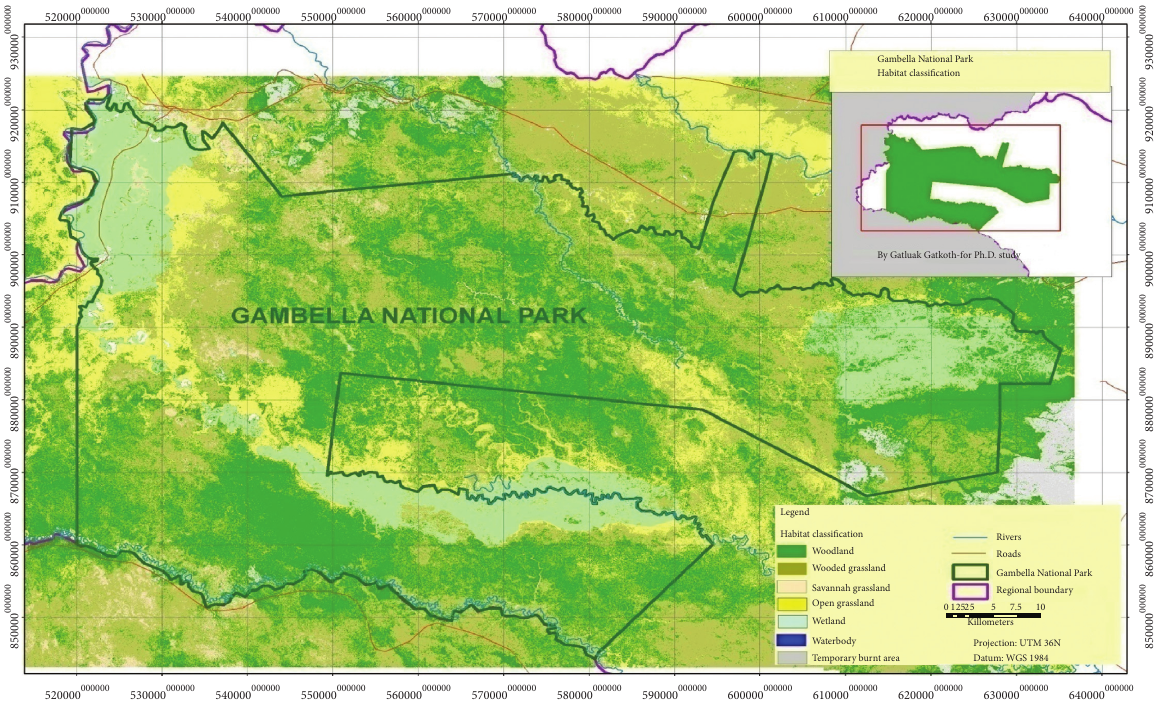
Figure 3: Habitat types of Gambella National Park. Table 4: Area covered by each habitat